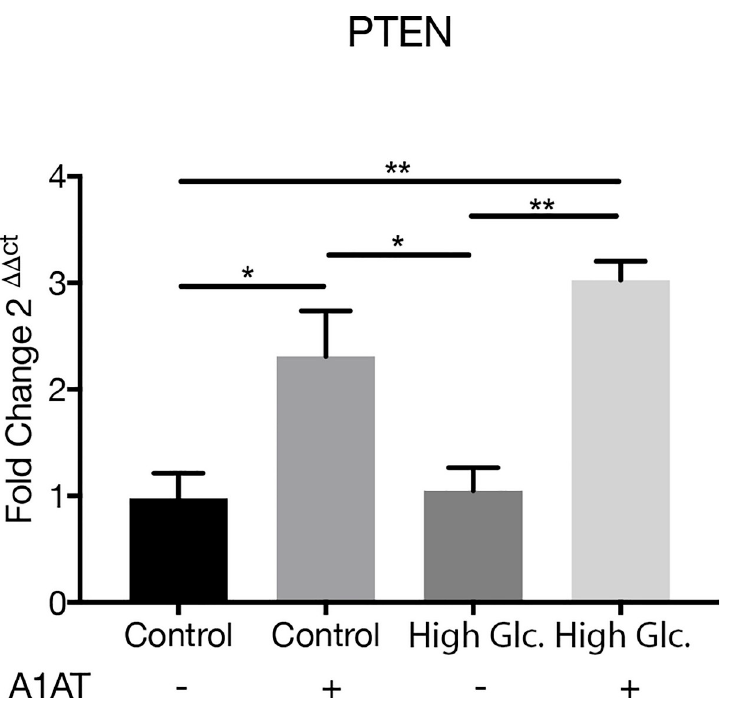
Fig 4. PTEN mRNA expression measured by RT-qPCR. High glucose group expressed as ‘High Glc’. Data expressed as fold change with respect to control mean ± SD. � p < 0.05, �� p < 0.01 vs. Control.